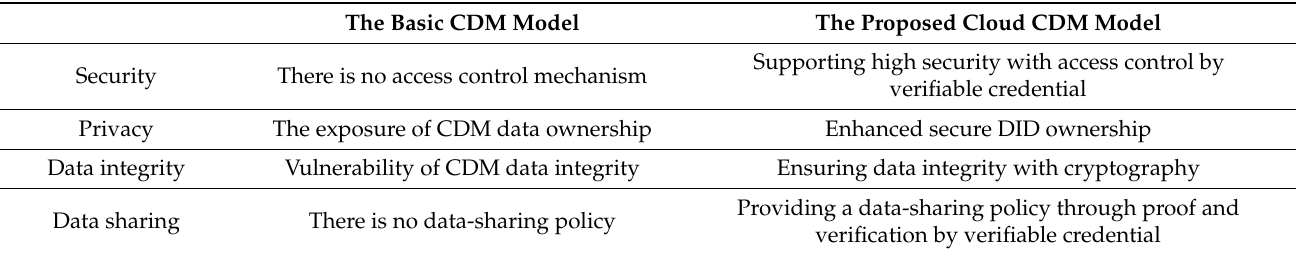
Table 2. Qualitative comparison of CDM models.